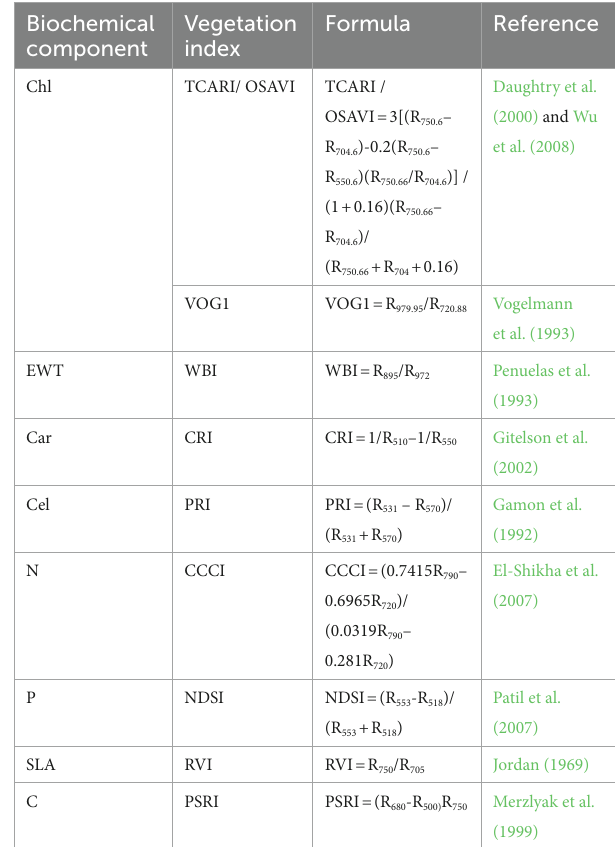
TABLE 1 Vegetation indices corresponding to the biochemical